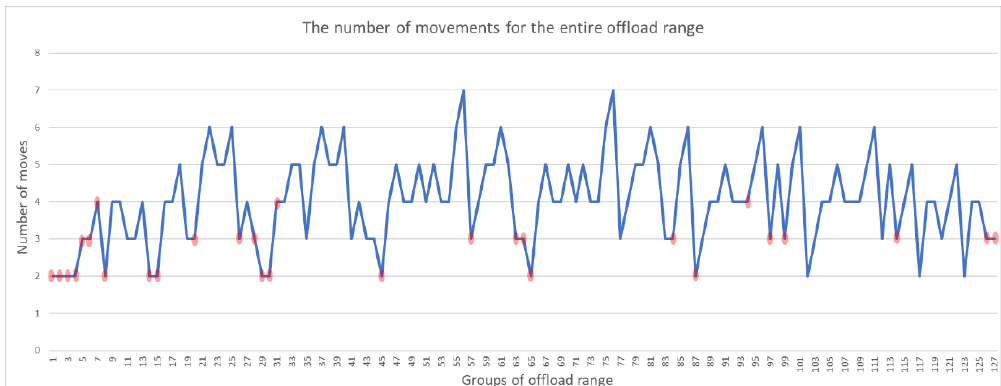
Figure 7. Graph the number of movements for the entire offload range. Table 4. Data & Task algorithm performance evaluation. All